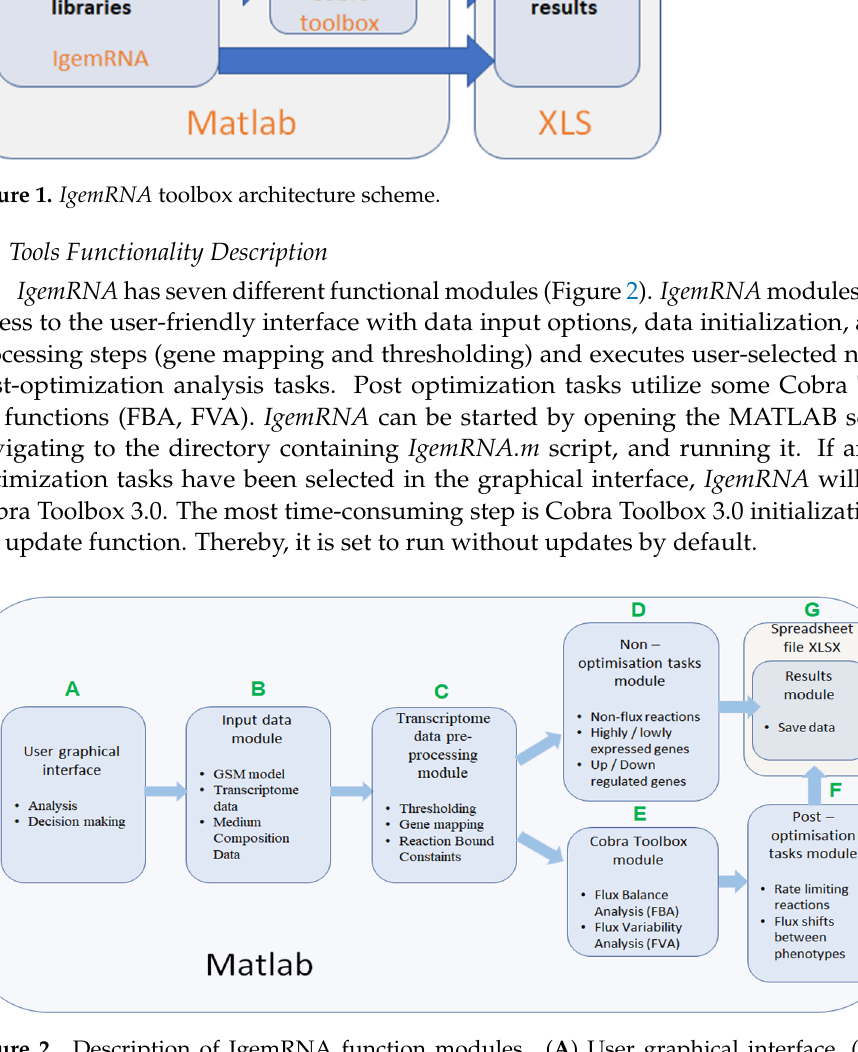
Figure 2. Description of IgemRNA function modules. ( A ) User graphical interface, ( B ) Input data module, ( C ) Transcriptome data pre-processing module, ( D ) Non-optimisation tasks module, ( E ) Cobra Toolbox module, ( F ) Post-optimisation tasks module, ( G ) Spreadsheet file